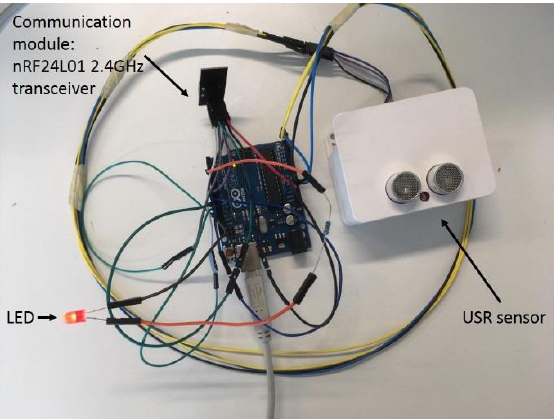
Figure 4. Prototype node realizing the suggested distributed sensing of a hidden Markov model (DS-HMM) architecture.